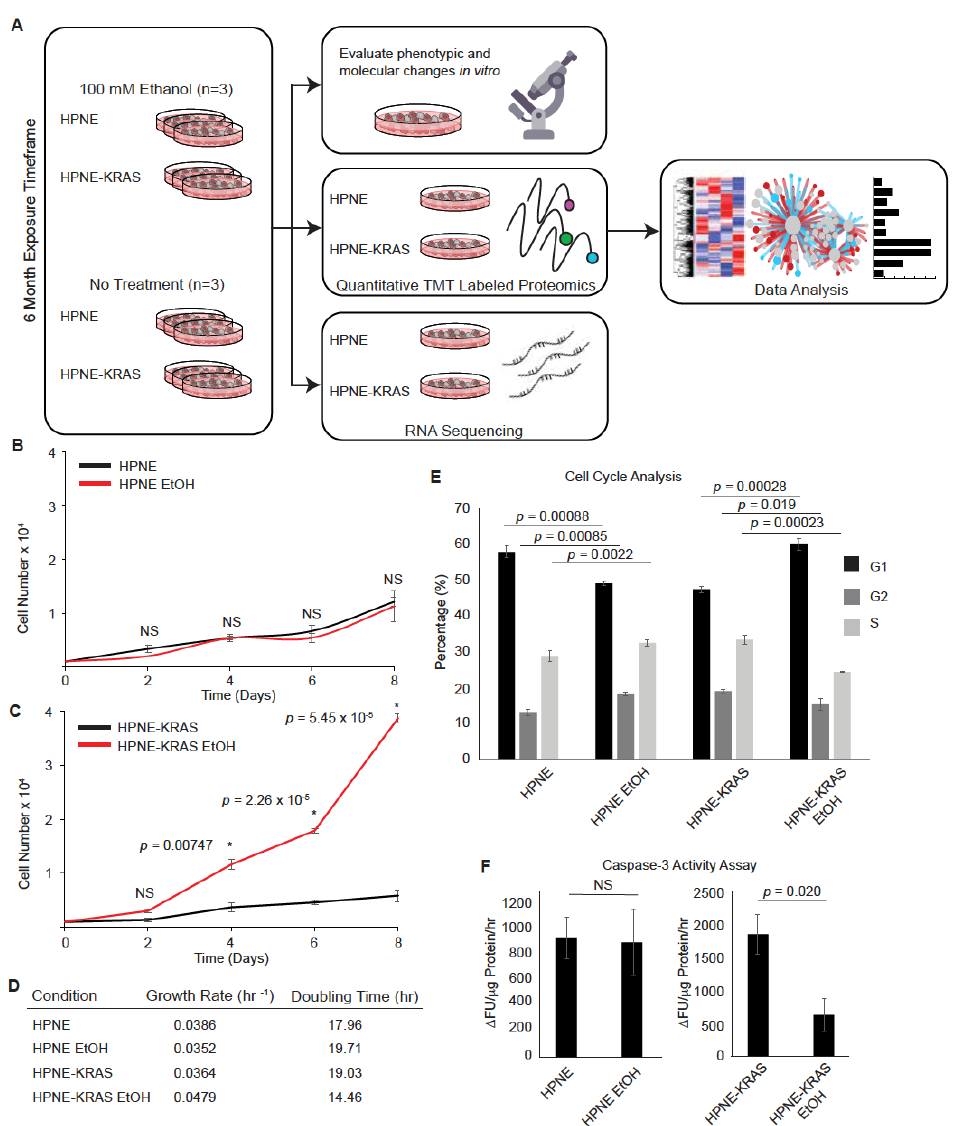
Figure 1. Ethanol promotes HPNE cell population expansion in a KRAS-dependent manner. ( A ) Schematic of the study design. RNA-Seq and quantitative proteomics were used to characterize the impact of EtOH conditioning in the context of KRAS mutations in non-transformed pancreatic HPNE cells. ( B , C ) Cell population growth curves. In total, 1000 cells were plated per well and counted every 2 days over an 8-day period for HPNE ( B ) and HPNE-KRAS ( C ) cell lines. Mean ± standard error of the mean (SEM); n = 3; significant p -values determined by Student’s t -test are indicated; NS, not significant; *, p -value ≤ 0.05. ( D ) Cell population doubling time determined from the cell counting study depicted in ( B , C ). ( E ) Cell cycle profiles were determined by PI staining and FACs analysis for the indicated cell lines and treatments. Mean ± SEM; n = 3; p -value determined by Student’s t -test. ( F ) The steady-state levels of Caspase-3 activity in the indicated cells and treatments represented as the change in fluorescent units per µg whole protein lysate per 1 h reaction time (∆FU/µg protein/hr). Mean ± SEM; n = 3.